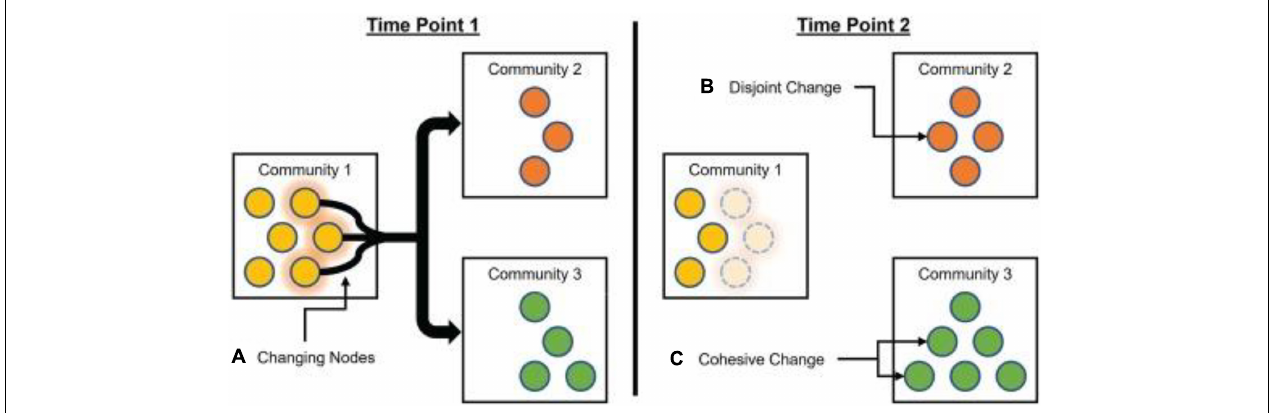
FIGURE 3 | Schematic of cohesive and disjoint community changes. From Time Point 1 to Time Point 2, one yellow node from Community 1 (A) moves on its own to Community 2 (B) . This represents a disjoint change, with the node moving independently of other nodes. At the same time, two yellow nodes move from Community 1 (A) to Community 3 (C) , as a group. This represents a cohesive change, with nodes moving in tandem with each other. Reprinted with permission from Telesford et al. (2017).